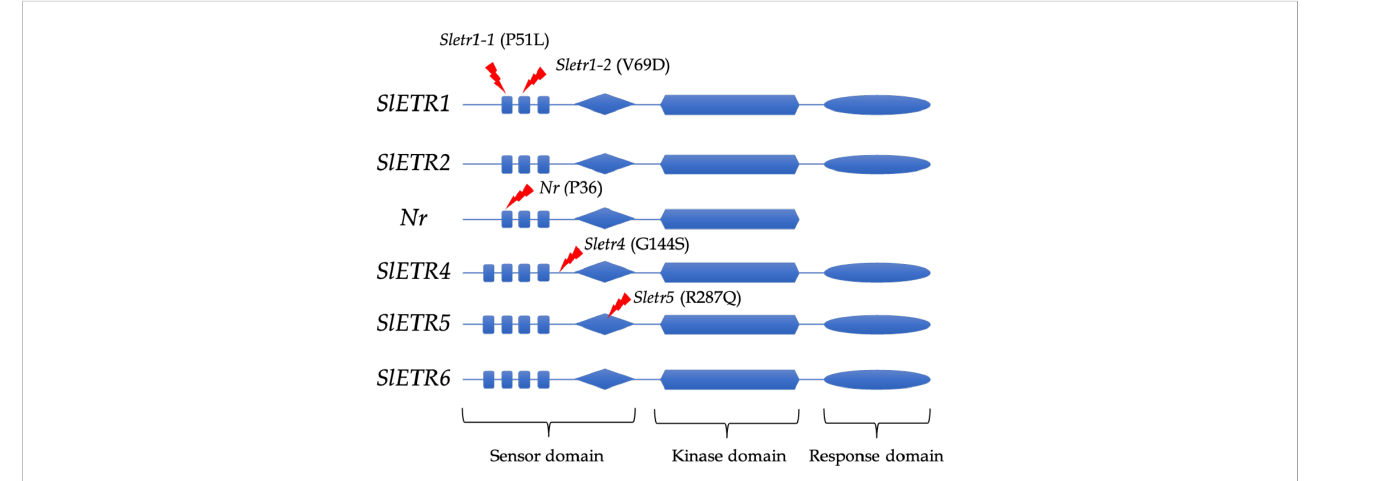
FIGURE 1 Mutation location of ethylene receptor mutants; Sletr1-1, Sletr1-2, Nr, Sletr4-1 and Sletr5-1